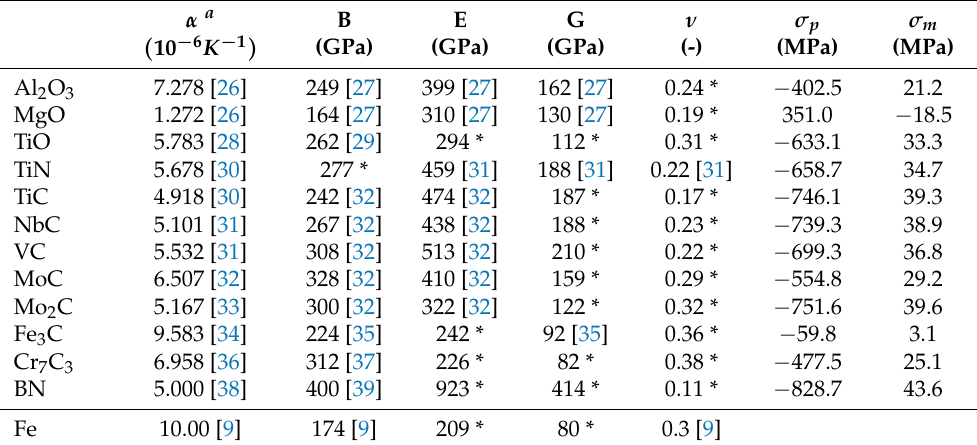
Table 1. Elastic and thermal properties and thermoelastic stresses for a number of precipitates at a volume fraction of 4% in an iron